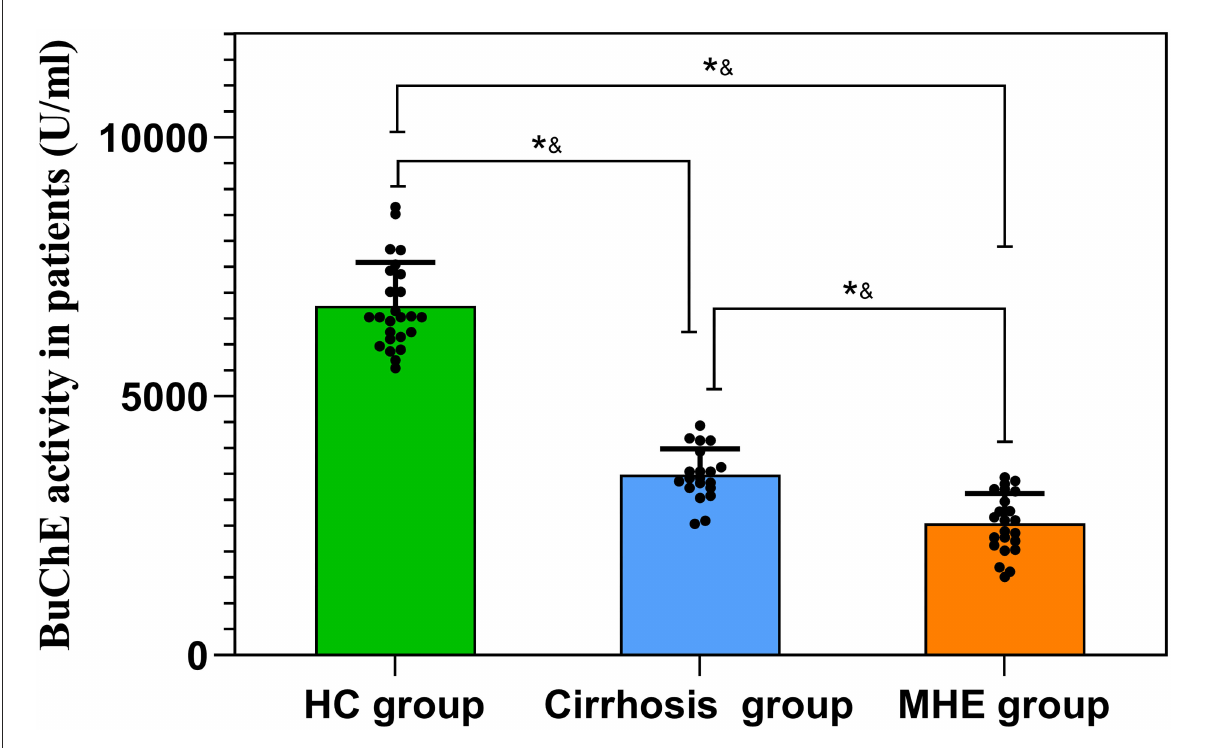
FIGURE1 Changes in serum BuChE activity with three groups, * P < 0.05, & Student’s t -test.